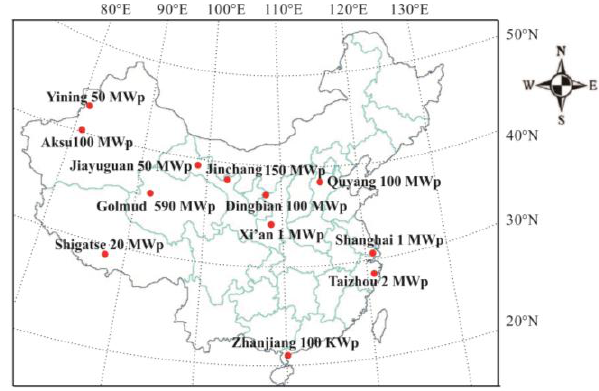
Figure 2. The distribution of photovoltaic power plant at different climate regions.